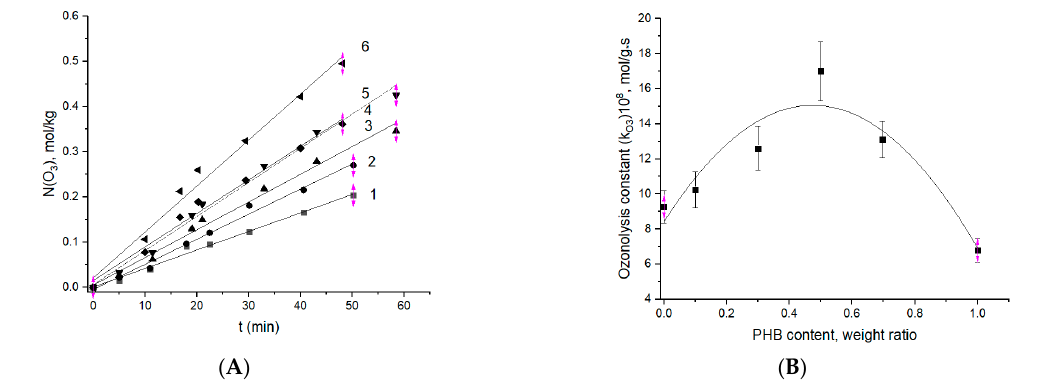
Figure 6. ( A ) Initial stage of ozonolysis for the fibers with different ratios—PHB:PLA (wt.%): 1—100:0; 2—0:100; 3—70:30; 4—30:70; 5—10:90; 6—50:50. ( B ) Effect of PHB content in the fibers on the effective constant ozonolysis.